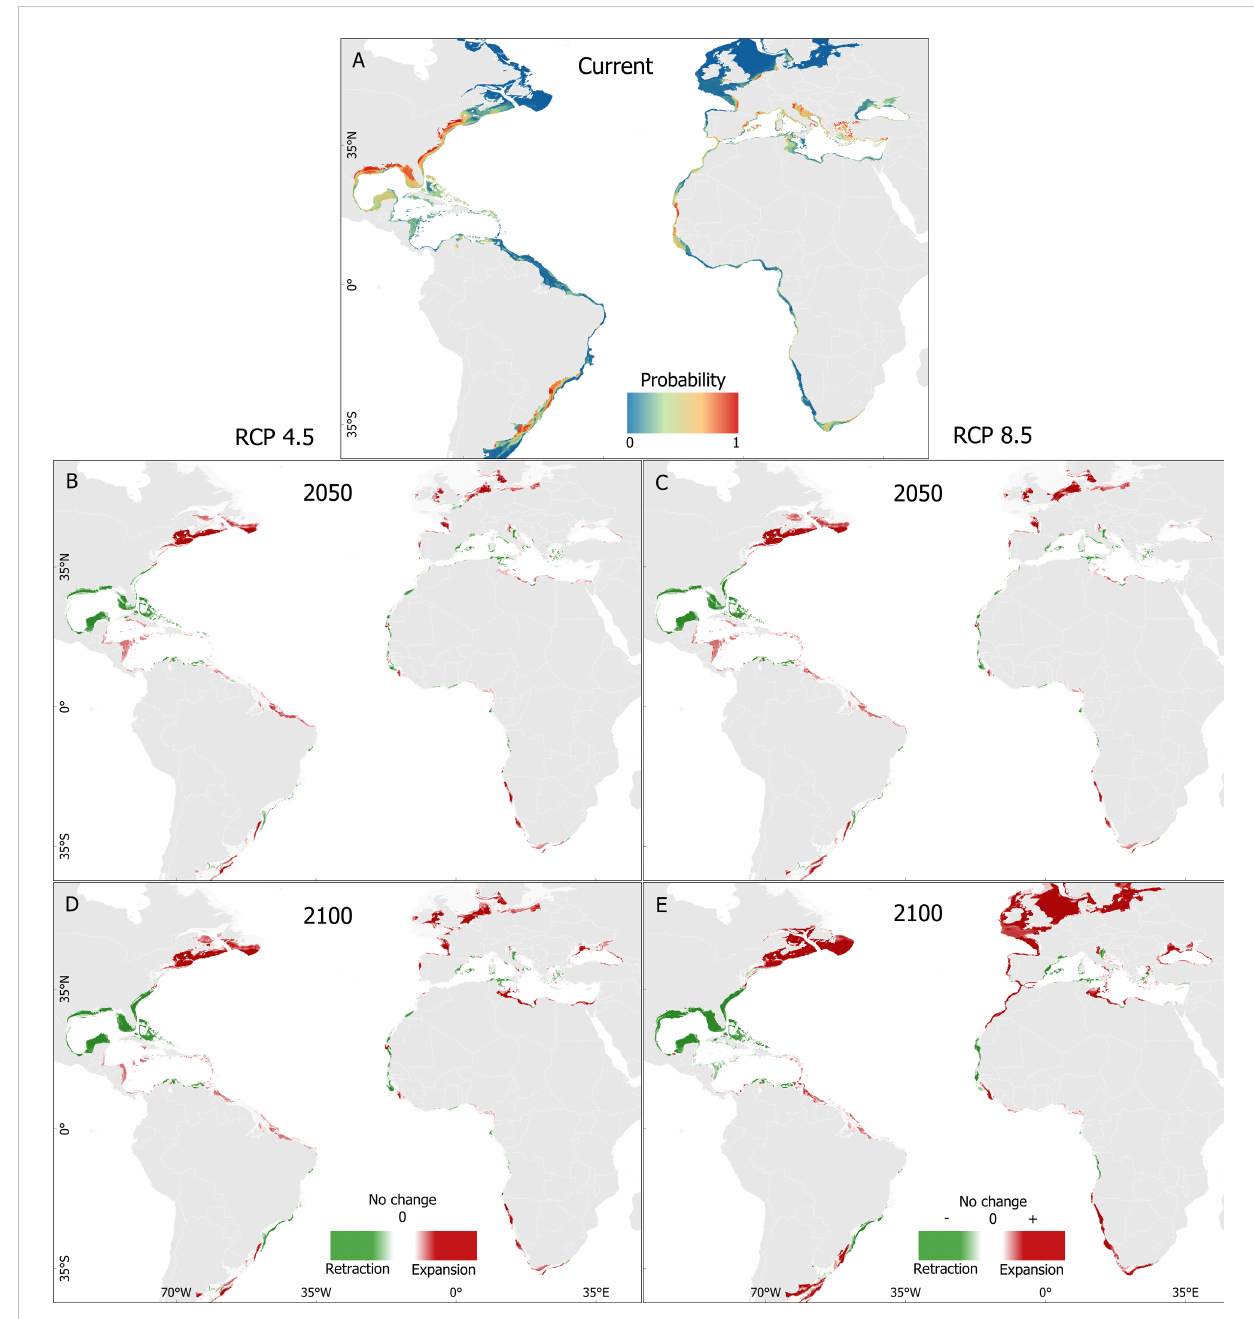
FIGURE 4 Predicted distribution of the Atlantic blue crab Callinectes sapidus Rathbun, 1896 (1832-2022) for posterior predictive mean for the BART model in the current scenario (A) and habitat range changes for the RCP 4.5 2050 (B) , RCP 8.5 2050 (C) , RCP 4.5 2100 (D) and RCP 8.5 2100 (E)